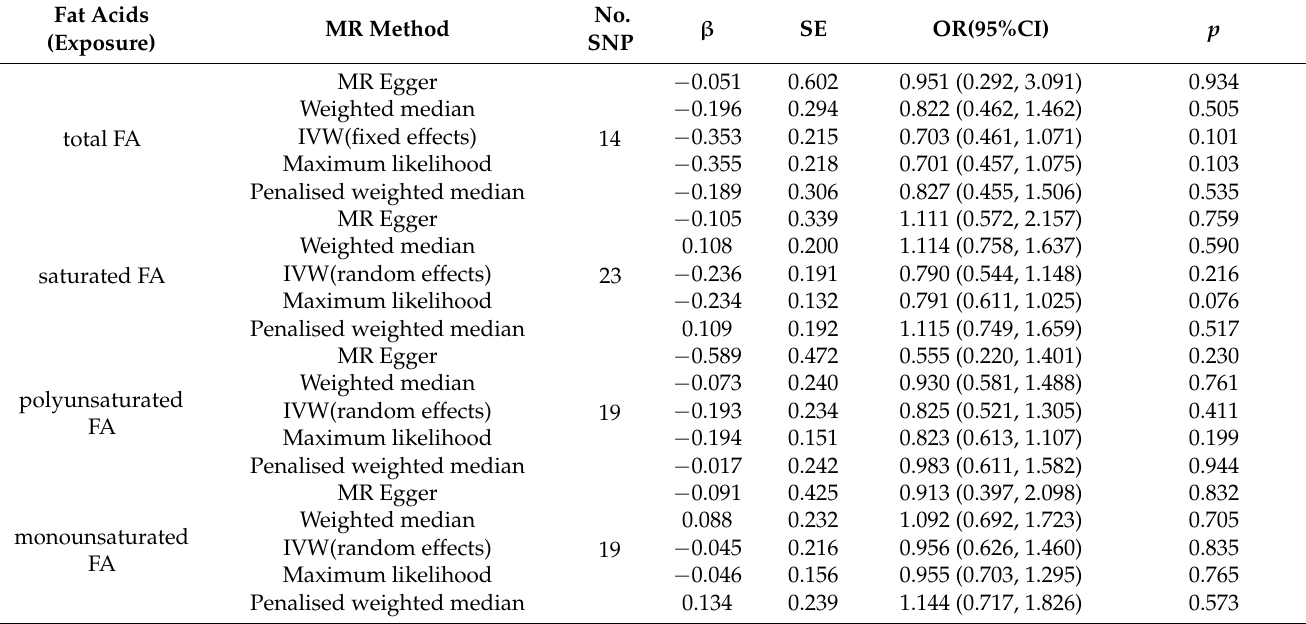
Table 3. MR analysis results of diverse fatty acids (FAs) and Ulcerative colitis